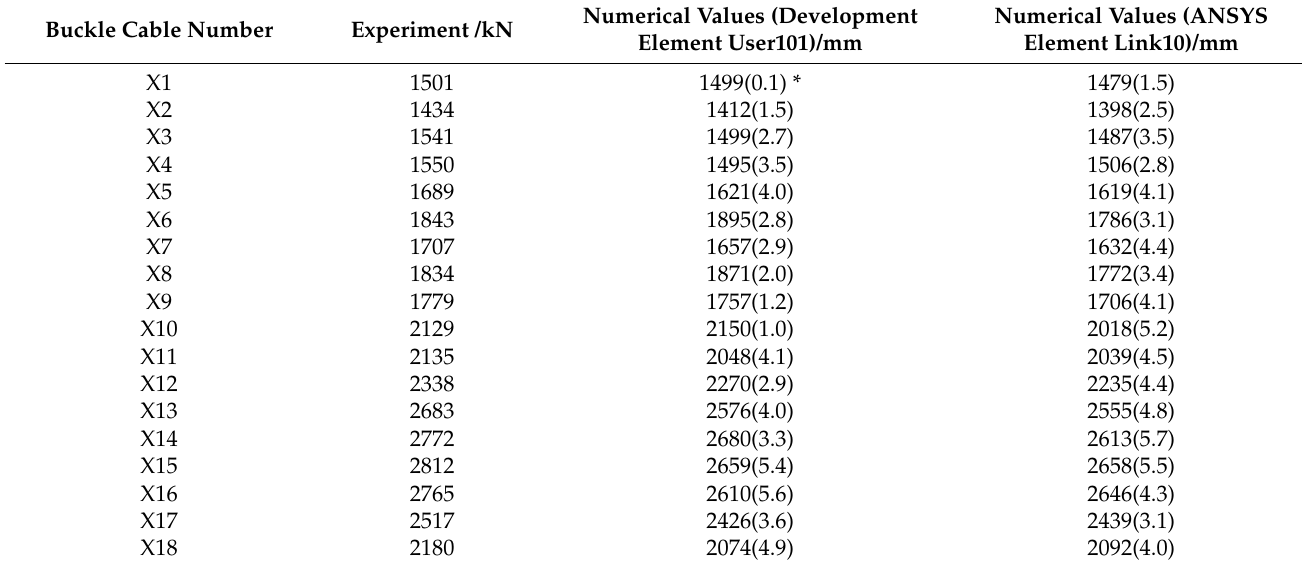
Table 8. Comparison of calculated and measured values of the maximum cable force of the arch ring buckles.